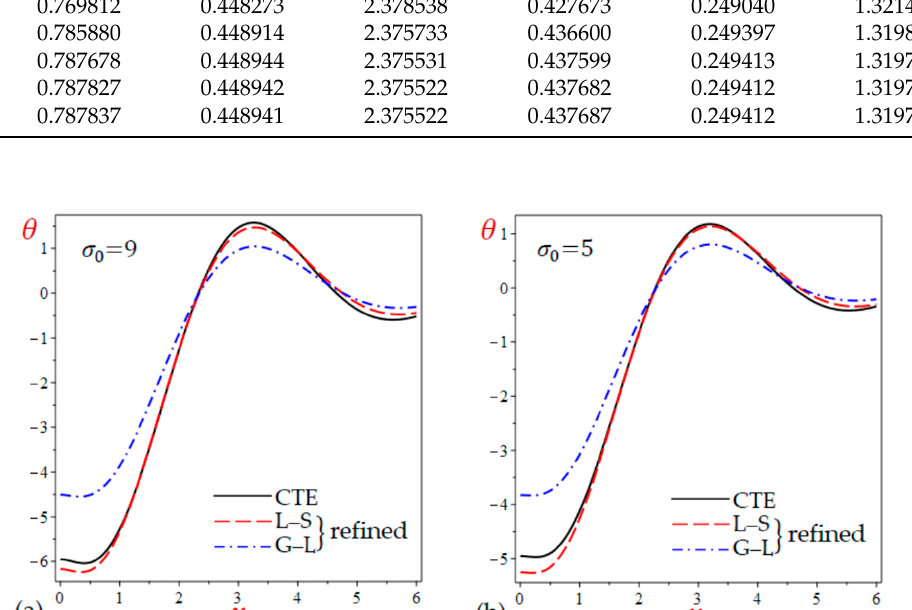
Figure 1. Effect of initial stress σ 0 on the temperature θ of the rotating half-space with initial pressure